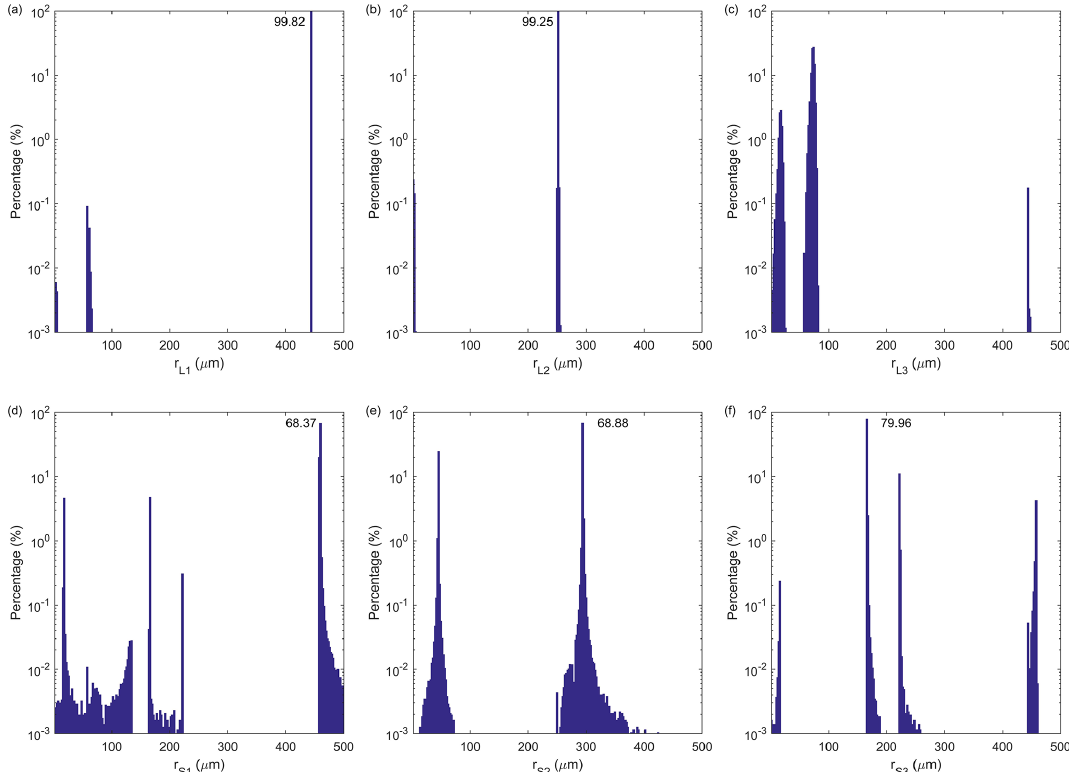
Figure 2. The distribution of occurrence frequency in percentage for GQ radius nodes: (a) the first node of latent heat flux, (b) the second node of latent heat flux, (c) the third node of latent heat flux, (d) the first node of sensible heat flux, (e) the second node of sensible heat flux, (f) and the third node of sensible heat flux. The peak frequencies are